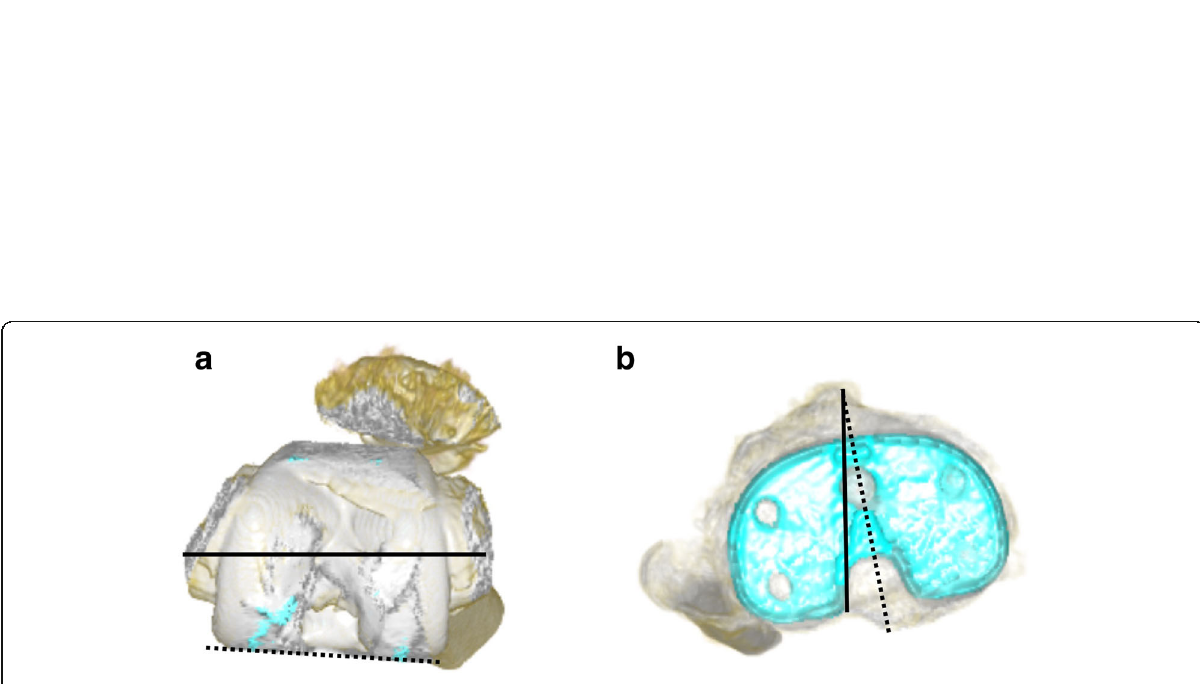
Fig. 3 Computed tomography analysis of the patient. a Femoral component installed in the proper position. Solid line represented transepicondylar line, broken line represented posterior femoral condylar line. b Tibial component installed in a position of mild external rotation rather than internal rotation. Solid line represented Akagi ’ s line, broken line represented antero-posterior axis of tibial prosthesis